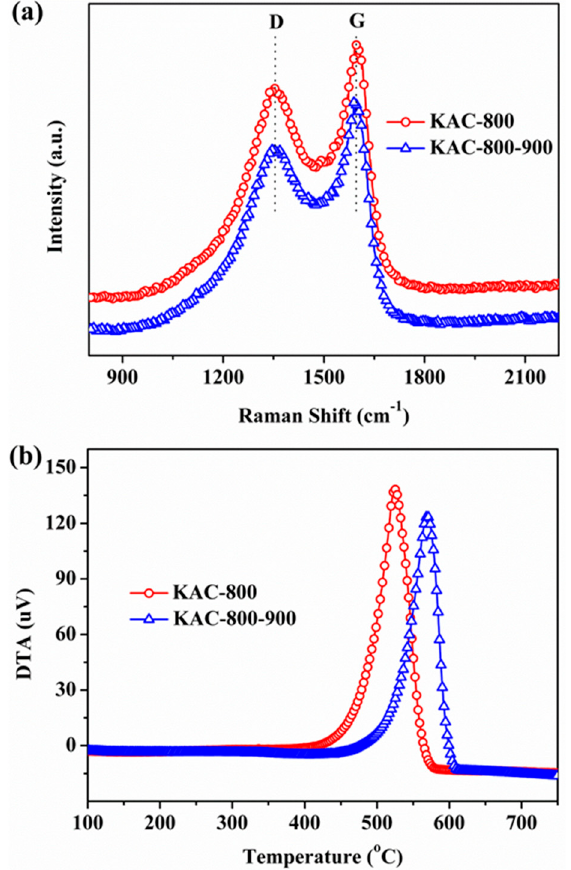
Figure 8. ( a ) Raman spectra and ( b ) DTA curves of KAC-800 and KAC-800-900.